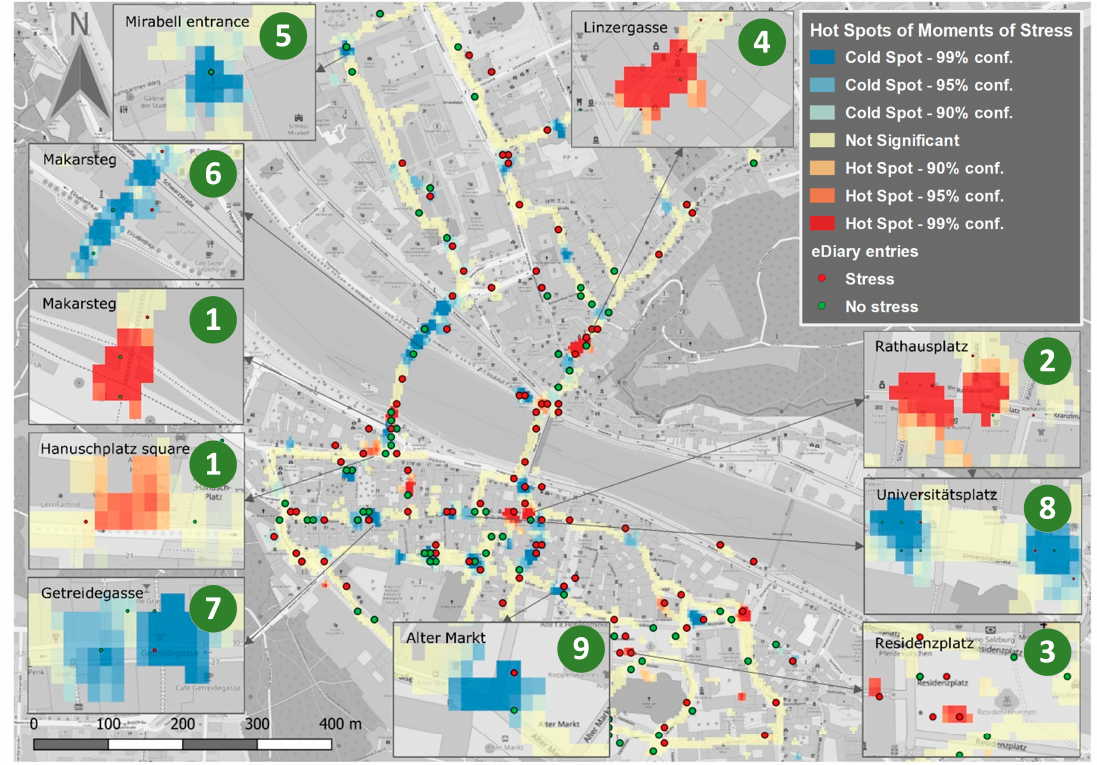
Figure 3. Walkability-related hot spots (stress clusters) and cold spots (areas of relaxation) in Salzburg (based on [10]).